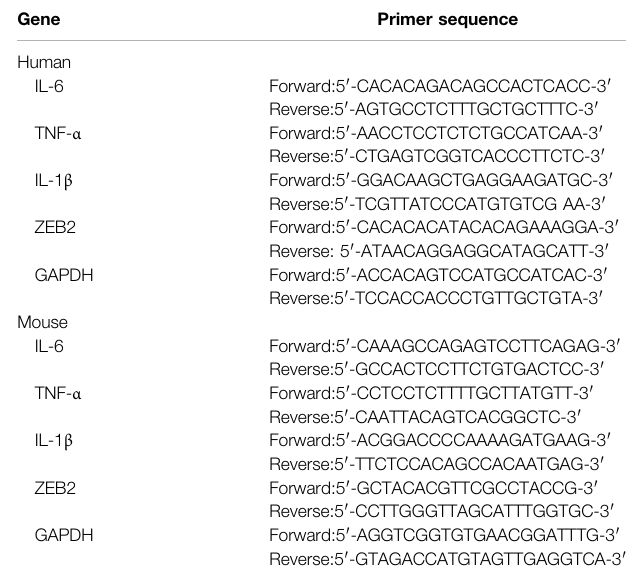
TABLE 2 | Primers used in real-time